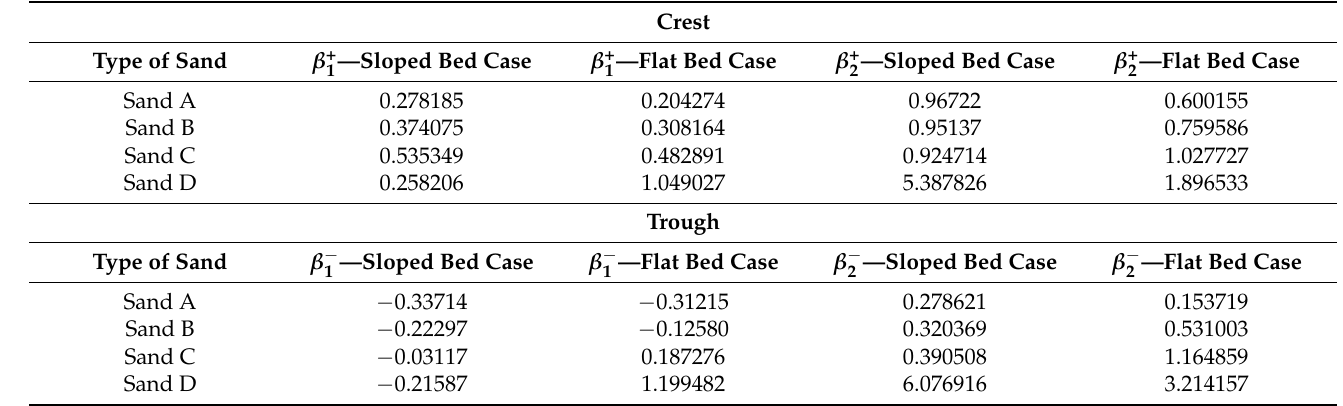
Table 5. Comparison of the correction factors over a sloping and flat seabed in the wave crest phase and wave trough phase.